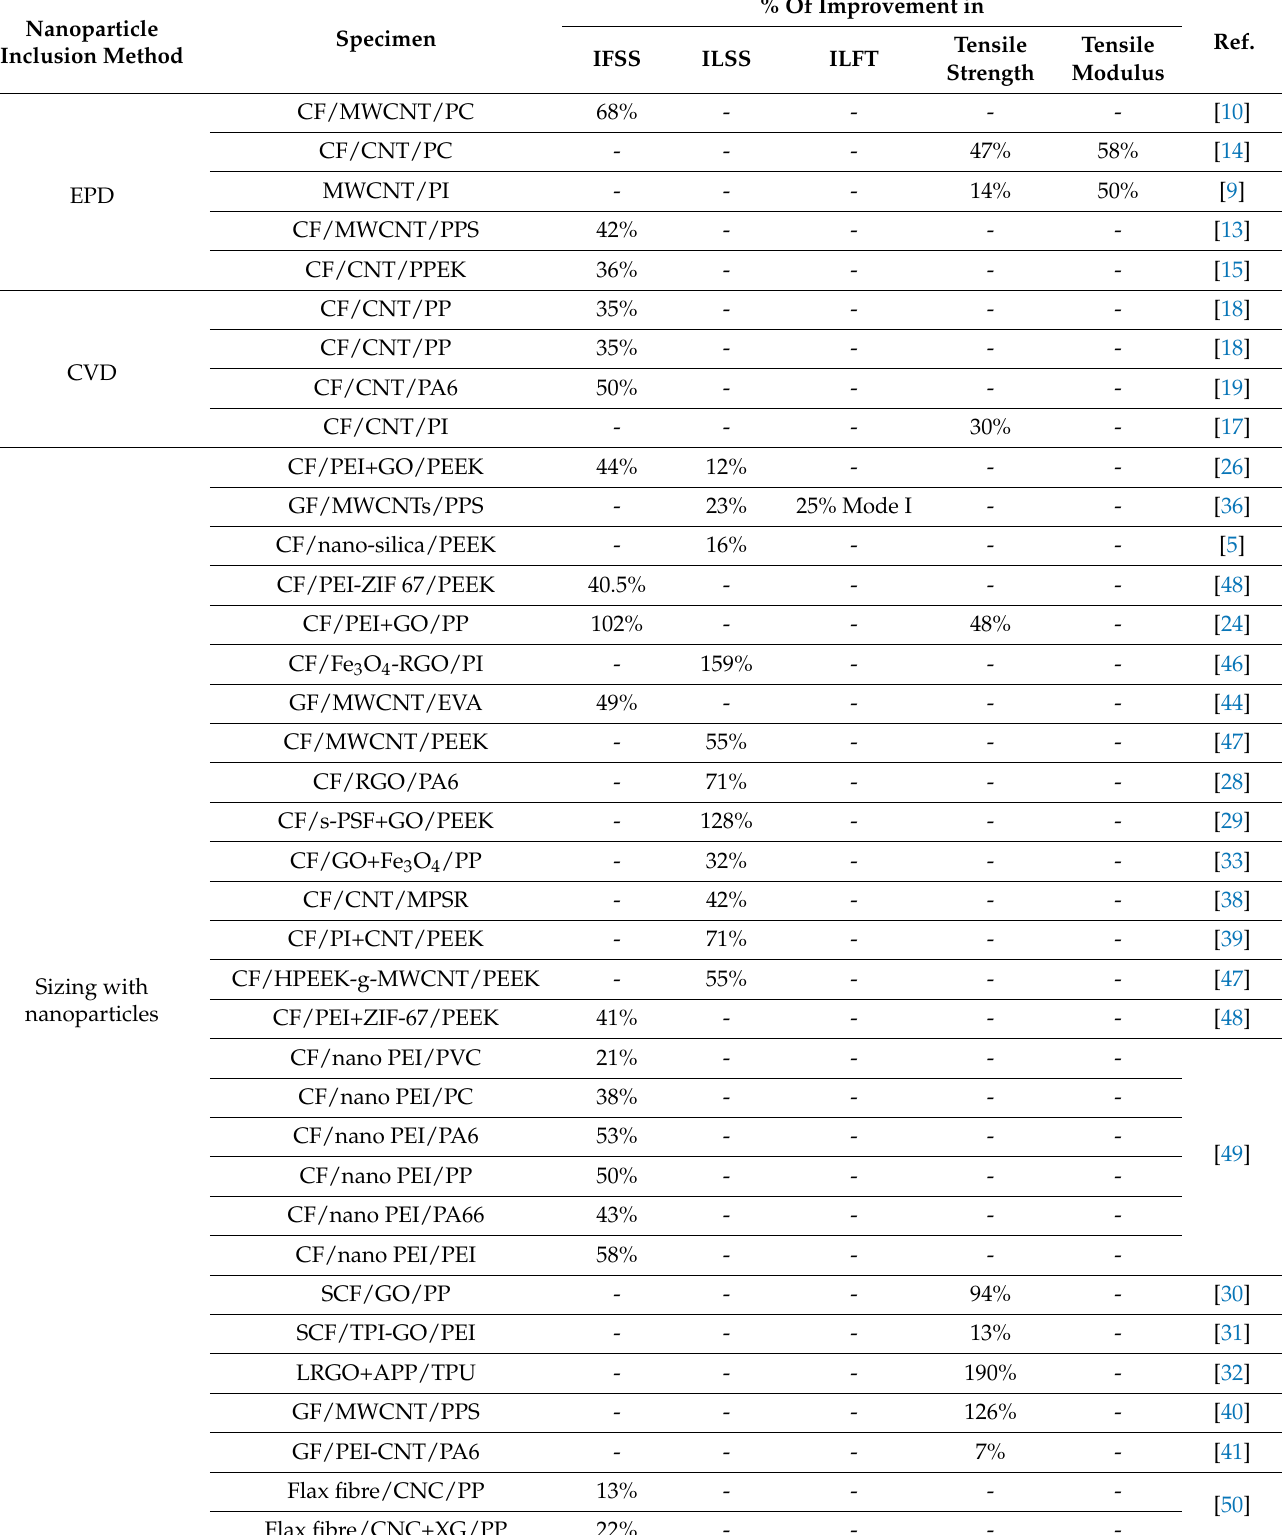
Table 1. Testing results from various nanoparticle inclusion